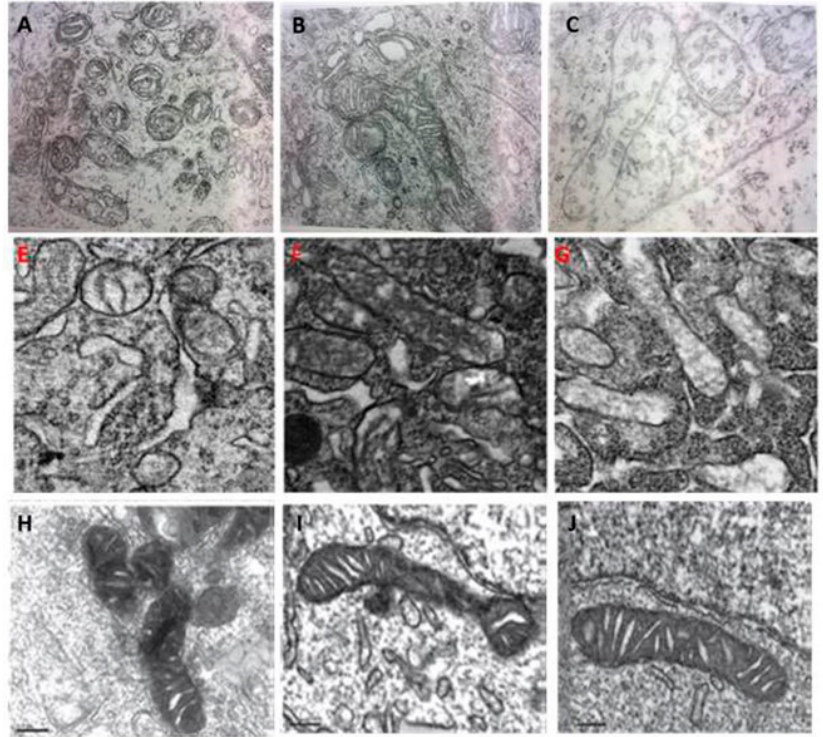
Figure 3. The similarities of mitochondrial dynamics in pinealocytes, brain neurons and cultured SH-SY5Y cells. Upper panel: Mitochondrial dynamics in pinealocytes (27,000×). ( A ) Condensed state; ( B ) Second intermediate state; ( C ) Third intermediate state; Middle panel: Mitochondrial dynamics in brain neurons of mice. ( E ) Mitochondrial fission induced by cadmium treatment; ( F ) The transition of mitochondrial fission and fusion in the animal treated with cadmium plus melatonin; ( G ) Mitochondrial fusion in control healthy animal; Lower panel: Mitochondrial dynamics in cultured SH-SY5Y cells (60,000×). ( H ) Mitochondrial fission induced by methamphetamine; ( I ) The transition of mitochondrial fission and fusion in cells treated with methamphetamine plus melatonin; ( J ) Mitochondrial fusion in control cells. The similarities of A , E and H ; B , F and I ; C , G and J are obvious. Mordified from [90,184,185].